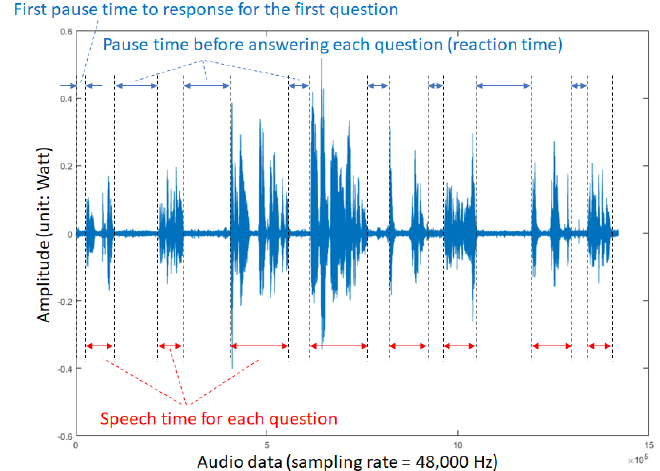
Figure 1. A plot of recorded audio of an introversive participant by using the matrix laboratory software (MATLAB).